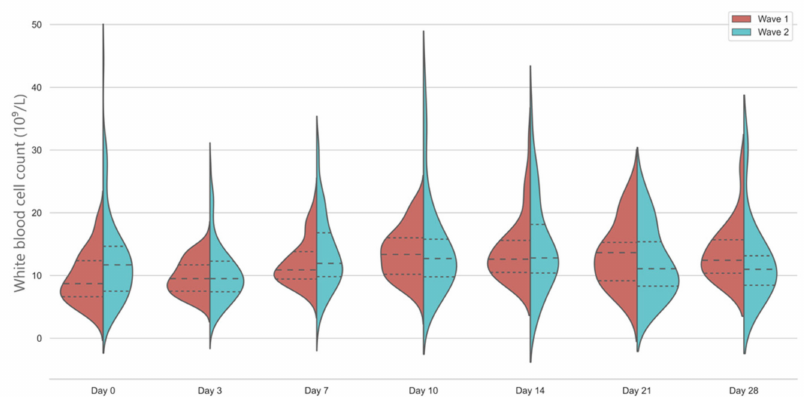
Figure 1. Temporal changes in white blood cell counts in the first and second wave. Violin plots represent the distribution of data. Dashed lines show medians and interquartile ranges. The general linear model indicates significant differences between days in wave 1 and between groups, p < 0.001.